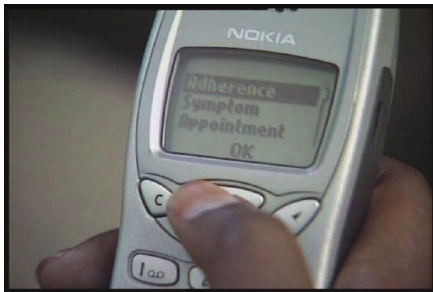
Figure 1: A typical menu from the WIG interface in the original ‘Adherence’ application, shown in use on a basic